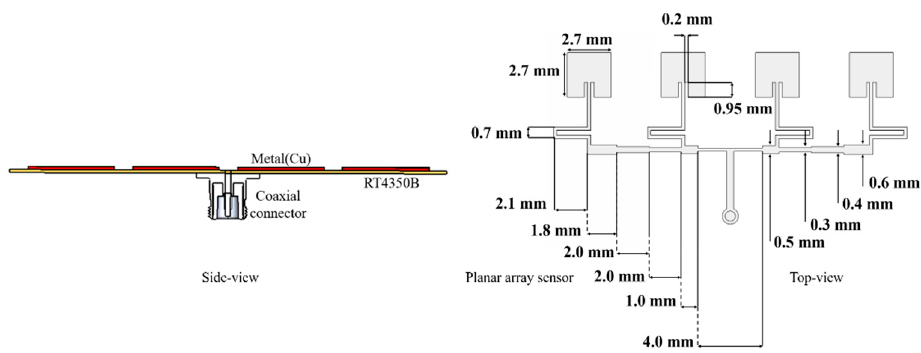
Figure 5. The resonator-array as the feed for the sensor: Side- and top-views of the